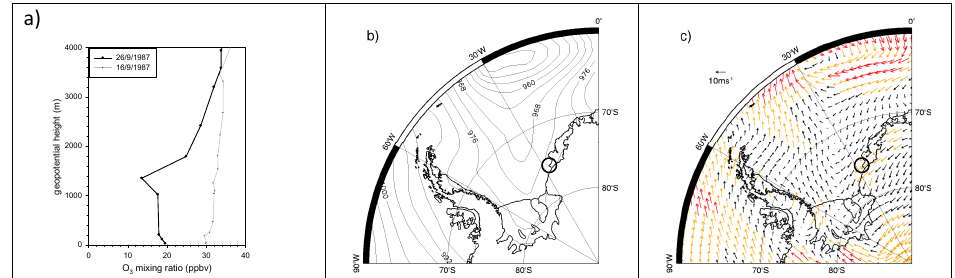
Fig. 14. (a) Ozonesonde measurements on 26 September 1987 compared with an un-depleted profile for the middle of the same month; (b) mean sea level pressure on 26 September 1987 (noon); (c) 10-m wind vectors on 26 September 1987 (noon) – wind speeds identified as: black = < 8ms − 1 ; orange = 8 to 12ms − 1 ; red = > 12ms − 1 . Halley is marked by the black circle on the